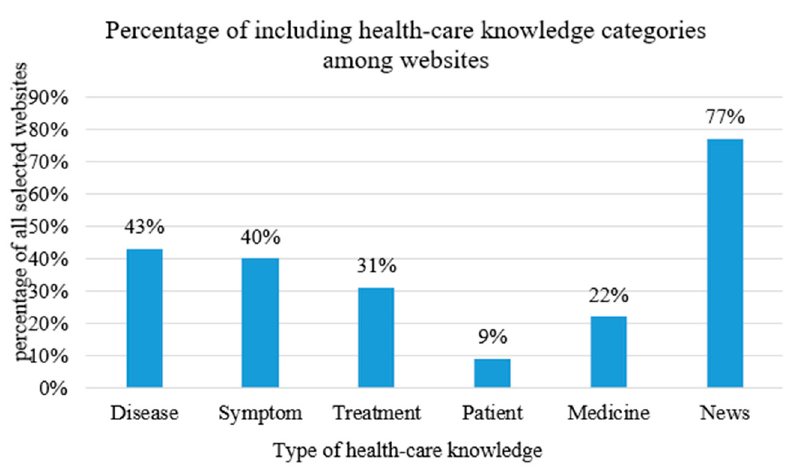
Figure 6. Percentage of including health-care knowledge categories among websites.